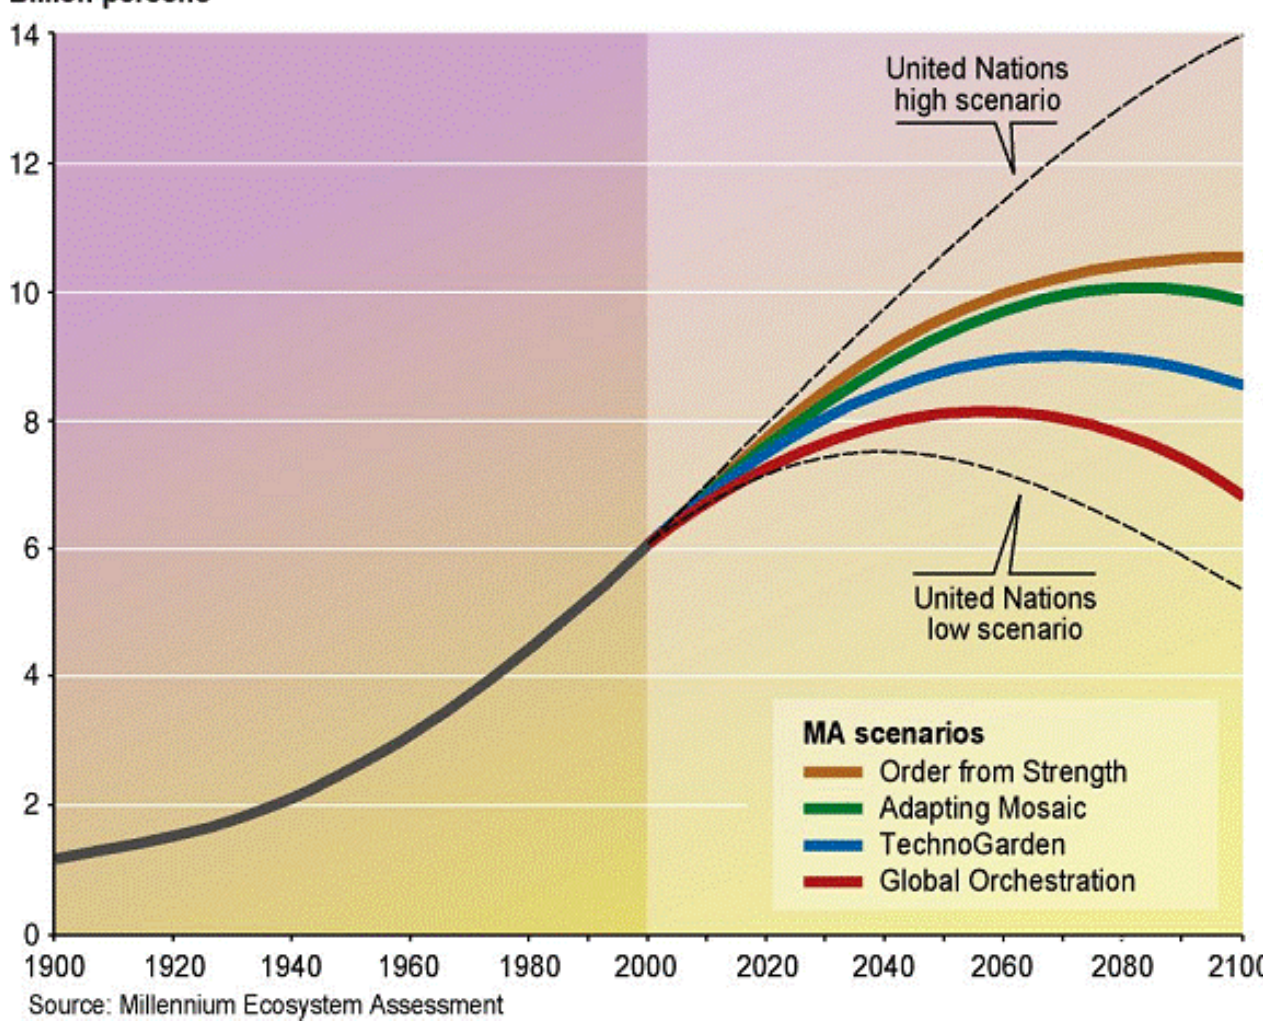
Fig. 4. Global population is shown in each scenario from 1900 to 2100. Population increase is lowest in Global Orchestration, peaking at just over eight billion in about 2060. Population growth is highest in Order from Strength, where population plateaus at over ten billion at the end of this